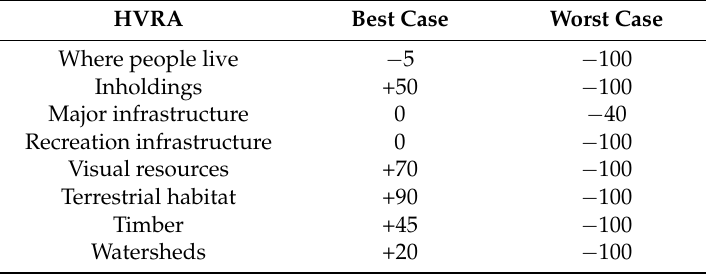
Table 2. Maximum (best case) and minimum (worst case) Response Function values for all major HVRA